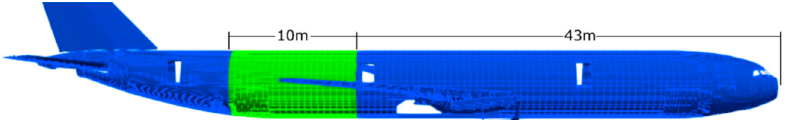
Figure 9. Relevant structural region (highlighted in green) of an A350-type aircraft .